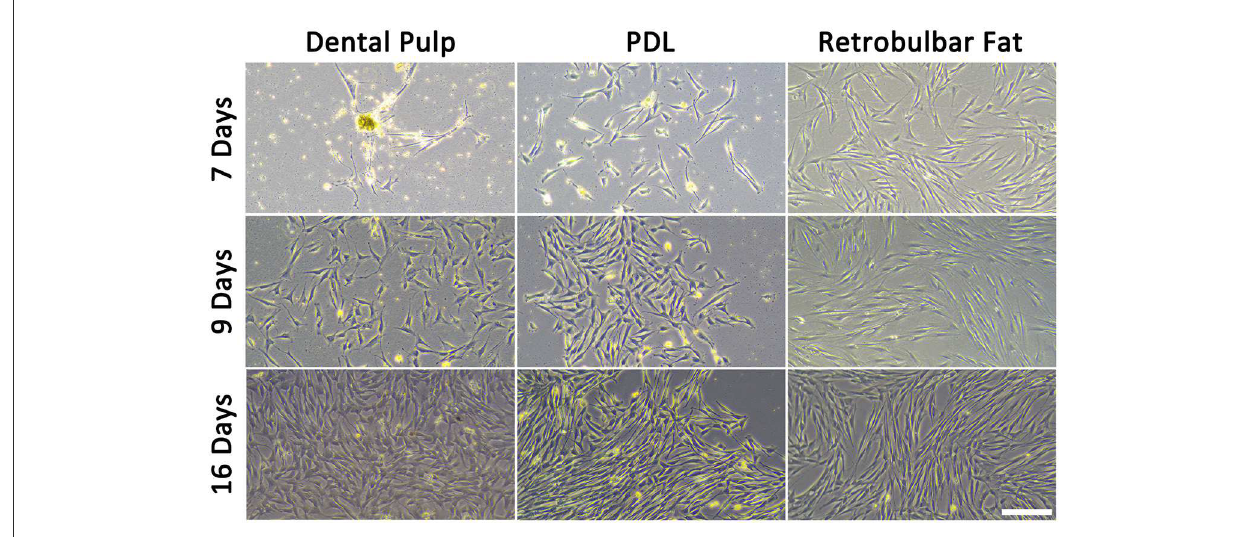
FIGURE5 Isolated MSCs after different time points. The scale bar represents 200 µ m.